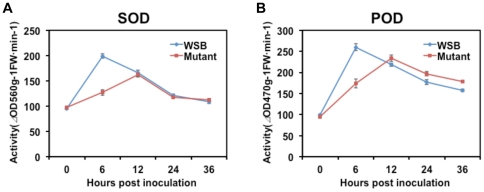
Activities of SOD (A) and POD (B) after F. graminearum infection in Wangshuibai and Meh0106 spikes.Each data point consisted of three replicates. Error bars indicate SD. WSB: Wangshuibai; Mutant: Meh0106.